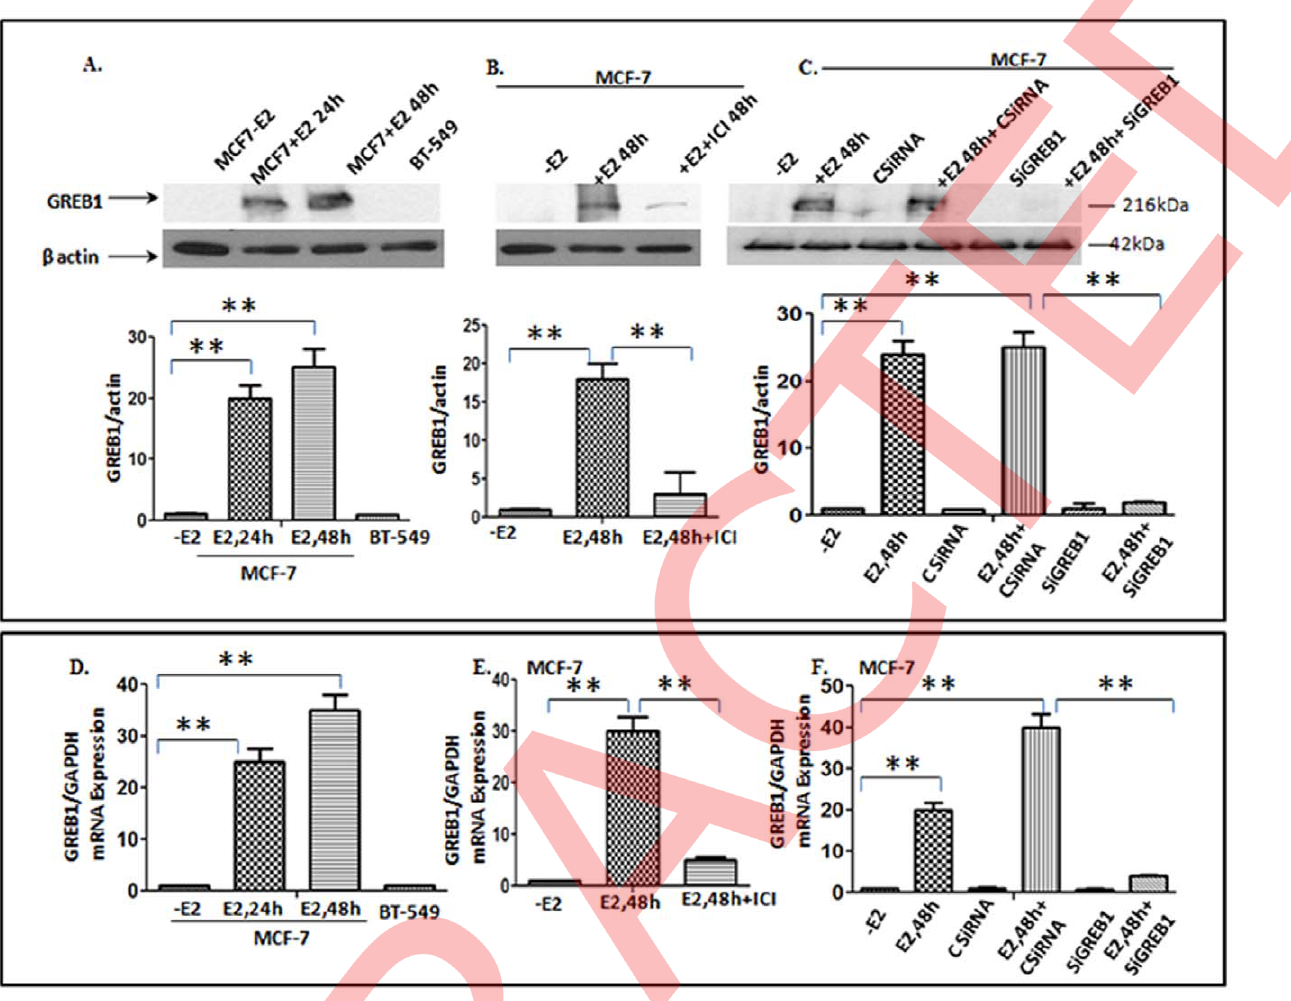
Figure 1. GREB1 is induced by E2 in ER-positive breast cancer cell lines. A, Western blotting detects a single band of , 216 kD in E2- deprived MCF-7 cells treated with estrogen for 24 and 48 hrs while no protein is detected in the ER-negative BT-549 cells or in MCF-7 cells grown in estrogen-free conditions. B, GREB1 protein expression was reduced in the MCF-7 cells treated with estrogen plus ICI 182,780 (ICI) compared to that observed in cells treated with estrogen alone. C, Figure C shows loss of detectable GREB1 protein when GREB1 is knocked down by GREB1 siRNA (SiGREB1) at 48 hours. Control siRNA (CSiRNA) has no effect on E2-induced GREB1 production. Corresponding densitometric analysis of the bands performed with the ImageQuant program (Bio-Rad) were shown below the Western blot. E2-induced GREB1mRNA levels were also analyzed, GREB1 mRNA levels were well correlated with GREB1 protein expressions. D, GREB1 mRNA is notable as early as 24 hours and lasts up to 48 hours as presented in a time course study. BT-549 cells express GREB1 mRNA as low as the control. E and F, ICI treatment (Figure 1E) and silencing the GREB1 gene (Figure 1F) significantly reduced the GREB1 expression at transcriptional level. Data are shown as mean 6 SD. * P , 0.05; ** P , 0.01.